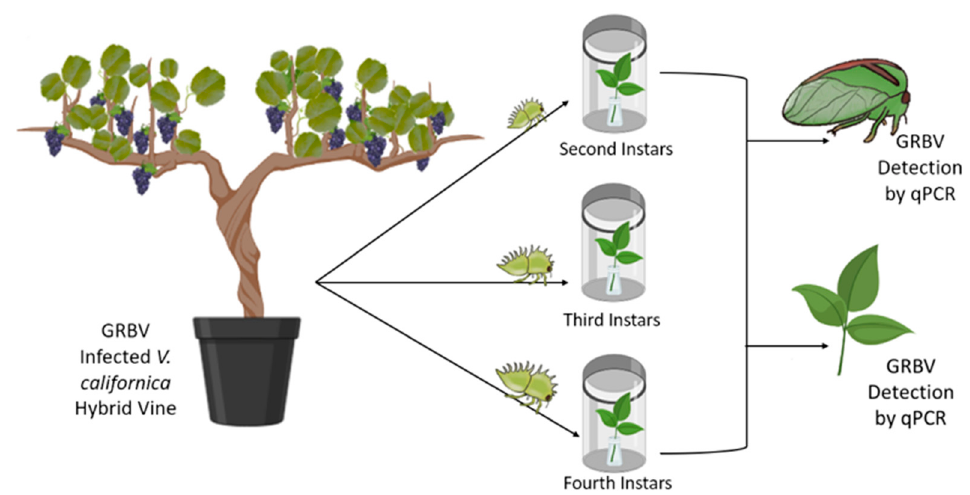
Figure 2. Schematic representation of the trans-stadial transmission assays performed in this study. Assays used GRBV-infected Vitis californica hybrid vines as donor material and healthy, detached leaves from Phaseolus vulgaris as recipient material. Virus donor plants were grown from hardwood cuttings of GRBV-infected free-living vines collected from northern California. Healthy excised snap bean leaves were placed in parafilm-covered 2-mL collection vials filled with sterile water and inserted into sealed polypropylene containers for exposure to second, third, or fourth instar Spissistilus festinus until adulthood. The artwork was produced using adapted art made by Brandon Roy and the program BioRender (Toronto, ON, Canada).